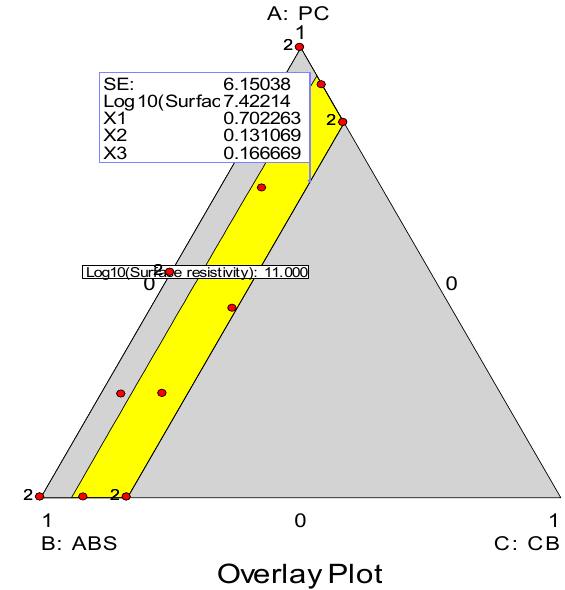
Figure 14. Overlay mapping @ 900 MHz with carbon black particles. Table 2. Optimized mixing ratio among PC, ABS, and CBm.